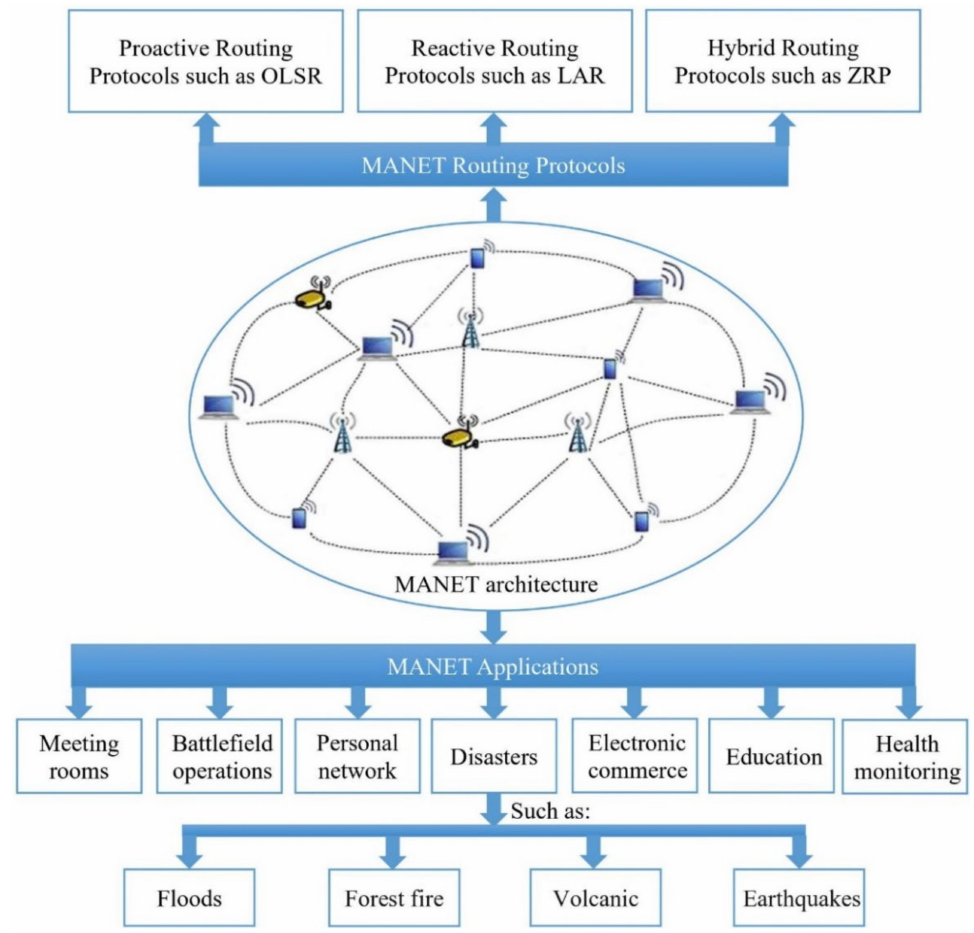
Figure 1. The MANET routing protocols and its